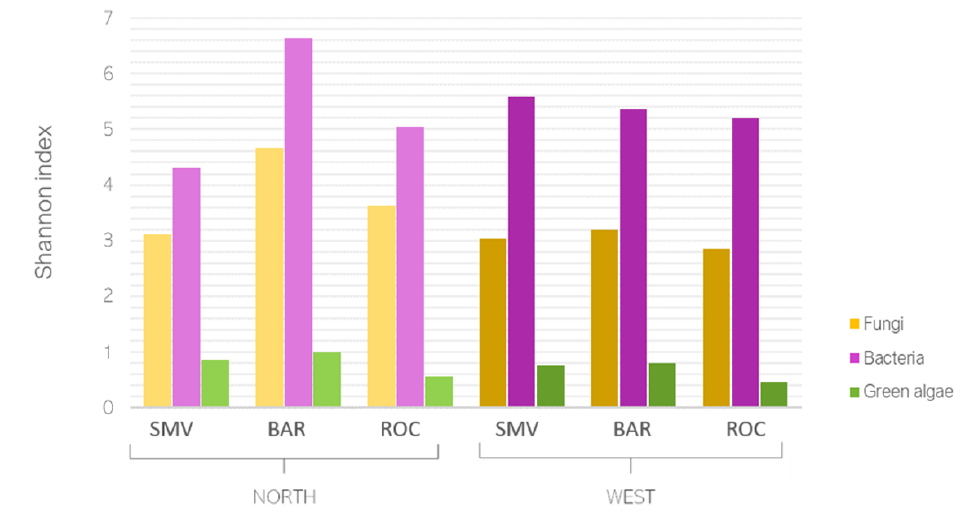
Figure 6. Shannon diversity index for green algae, fungi and bacteria colonizing the three churches under study (SMV, ROC, and BAR).